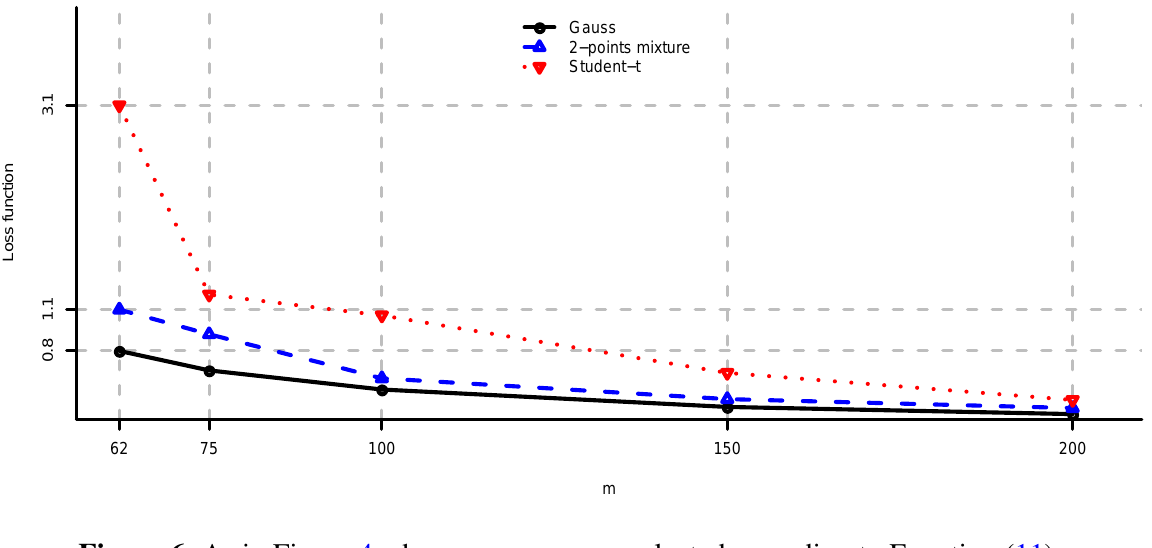
Figure 5. As in Figure 4 where c